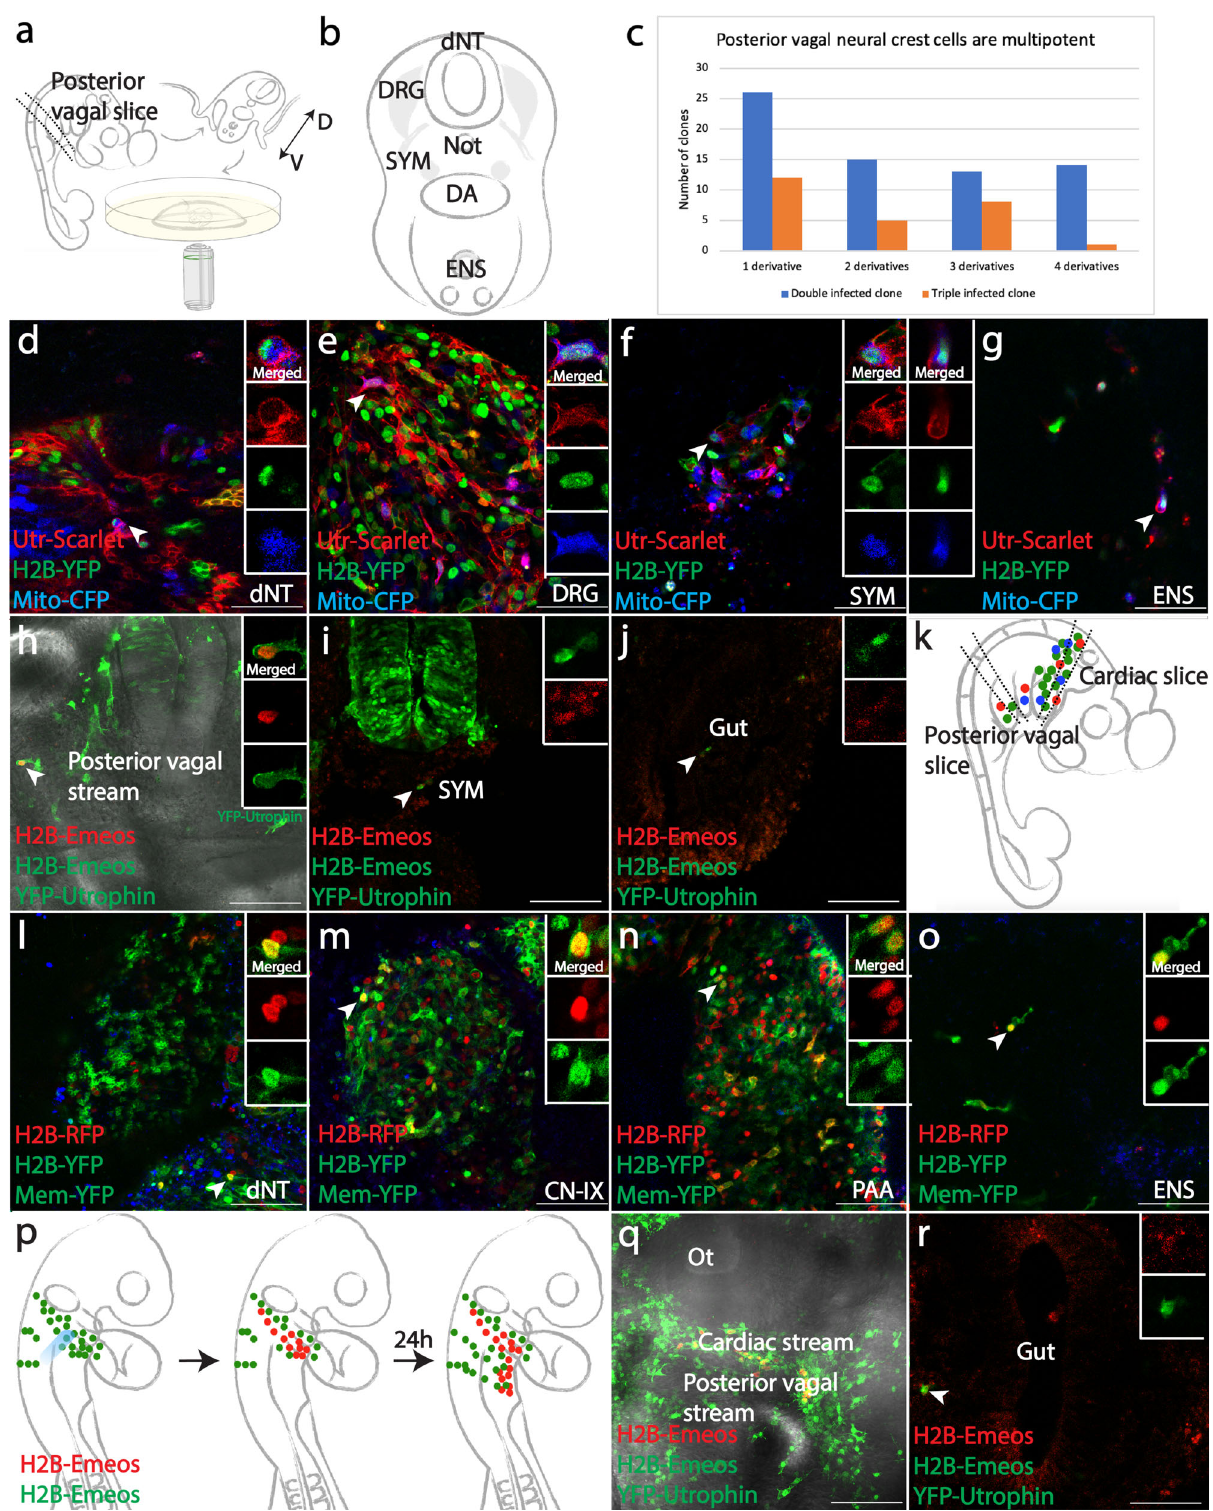
To validate the types of derivatives formed by clonally related cells, we used several markers that re fl ect mature cell type markers. Antibodies against HuC/D and TuJ1 were used to detect mature neurons, tyrosine hydroxylase (TH) for sympathetic neurons, P0 for Schwann cells and smooth muscle actin (SMA) as a mesenchymal cell fate marker in mature pharyngeal arch arteries. Analysis of immuno fl uorescence showed that at E7,